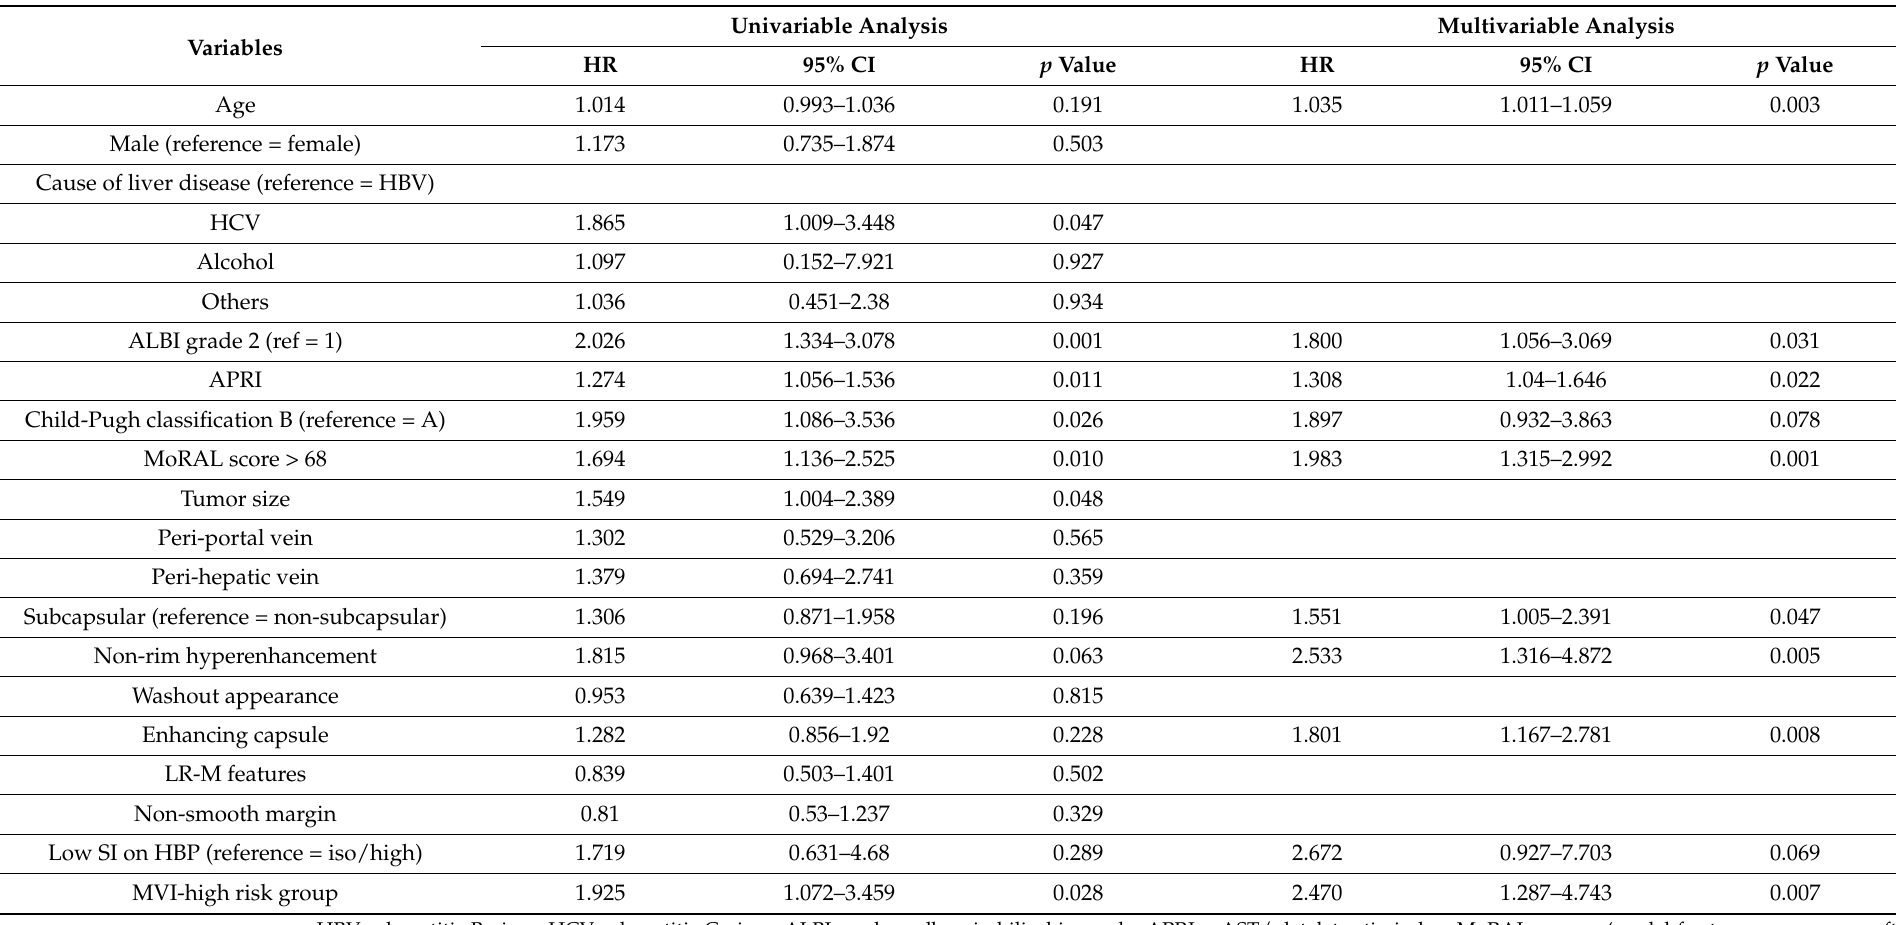
Table 2. Univariate and multivariate analysis using stepwise variable selection for prediction of recurrence-free